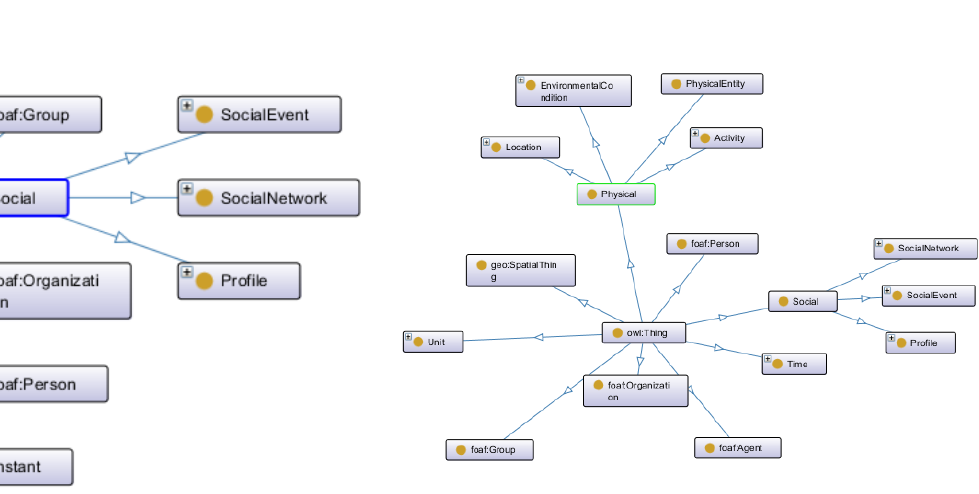
Figure 4. AndroCon Integrated Context